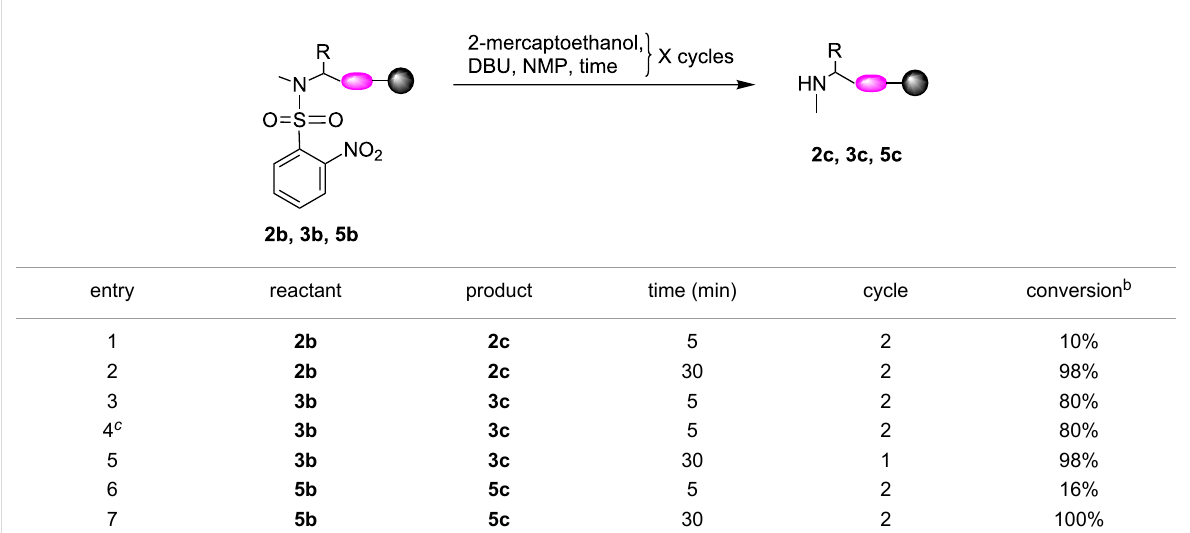
Table 3: Optimization of the o -NBS removal reaction (step iii) a .